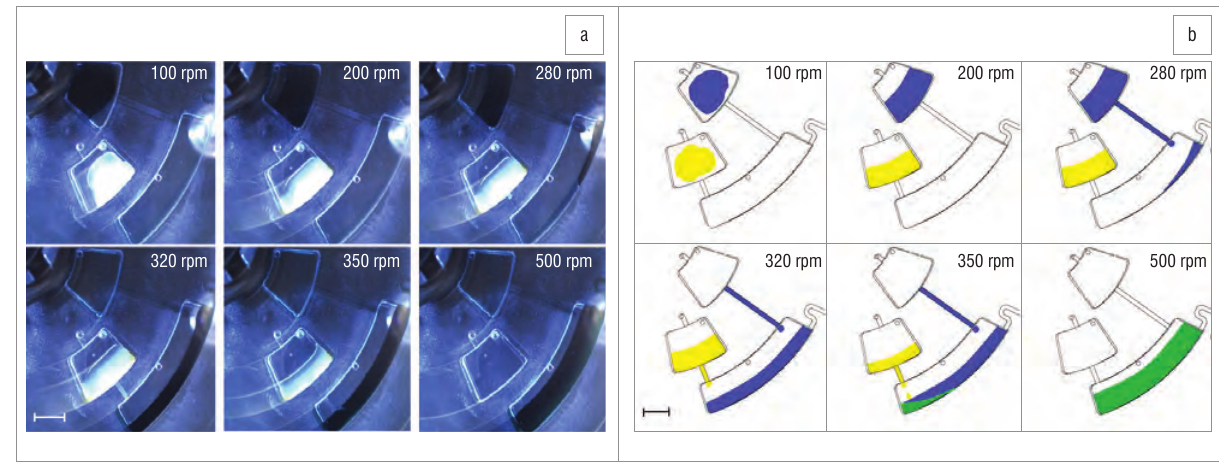
Microfluidic disc design to illustrate the introduction, combi- nation and sedimentation of samples and reagents, with applications for blood testing.